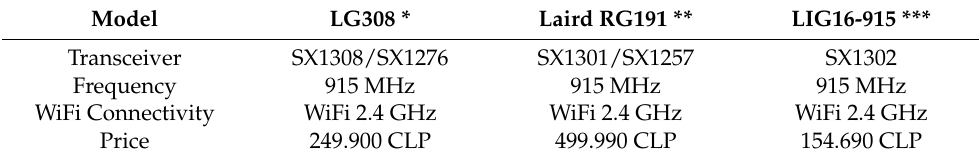
Table A4. Characteristics of LoRa